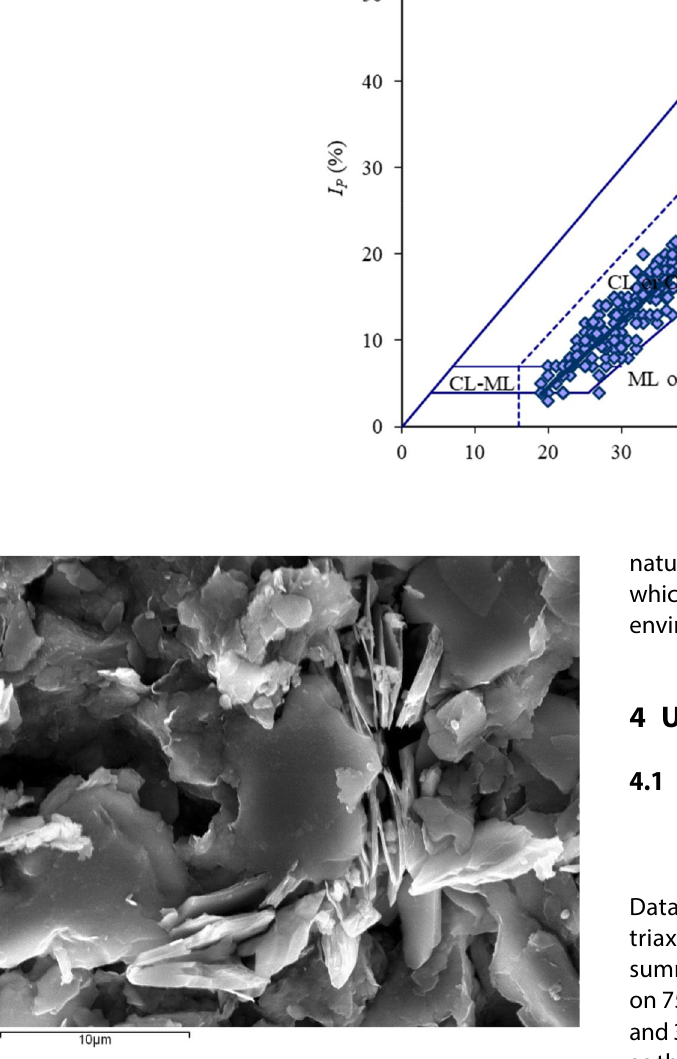
Fig. 4 SEM observations of Prazeres Clays, showing compact domains of clay particles